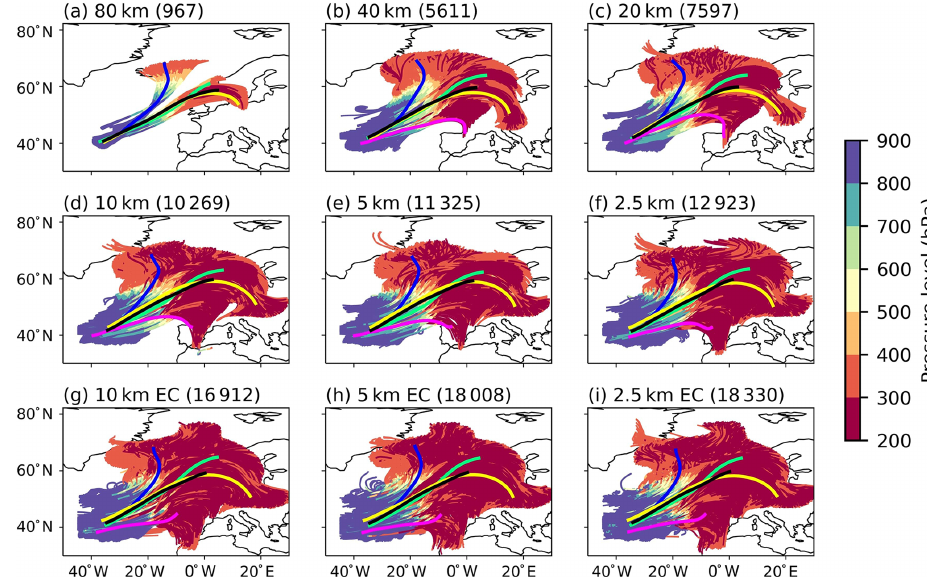
Figure 3. Same as Fig. 2 but for the simulations with two-moment cloud microphysics.